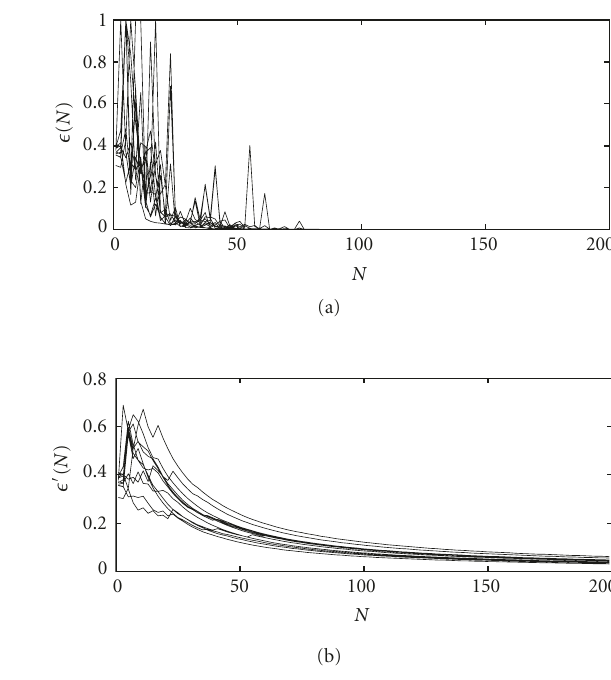
Figure 10: Case (C-3): (a) magnitude and (b) phase of ATF from demigration (solid line) and its model with N = 31 (dashed line). Magnitude and phase of model have an o ff set for better compara- bility.